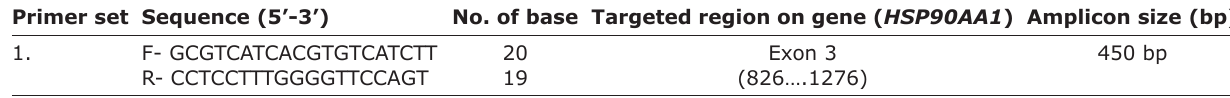
Table-1: Primer sequences, targeted region, and amplicon sizes of bovine HSP90AA1 gene. Primer set Sequence (5’-3’)